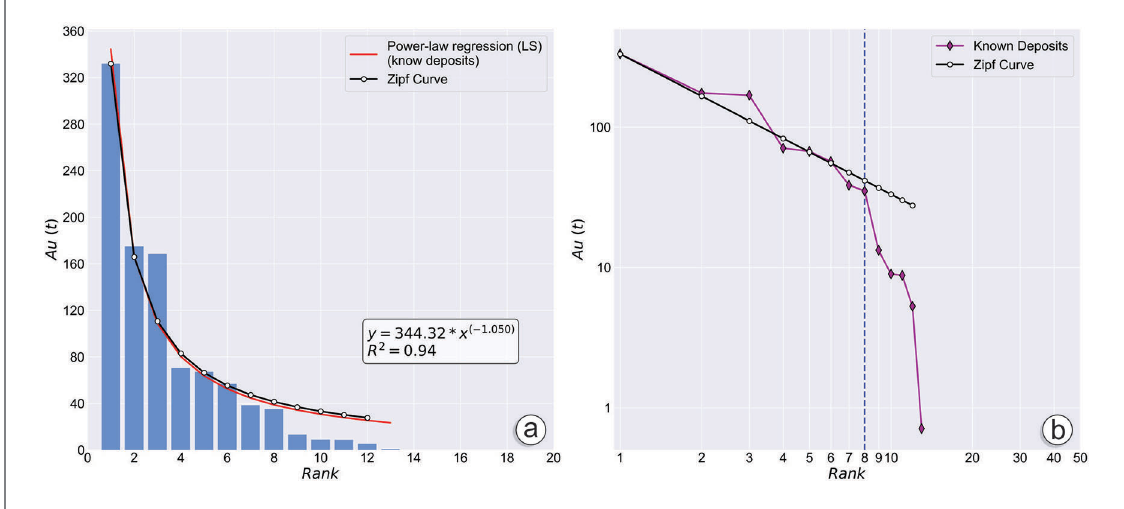
FIGURE 2 - a) Descending order rank of known gold deposits of Quadrilátero Ferrífero with the power-law curve estimated by least-square regression (red line) and the Zipf’s curve (black line). b) Log-log rank-size plot showing the known gold deposits and the Zipf’s curve (black). The dashed vertical blue denotes rank 8, where the deposits start to move away from the Zipf’s